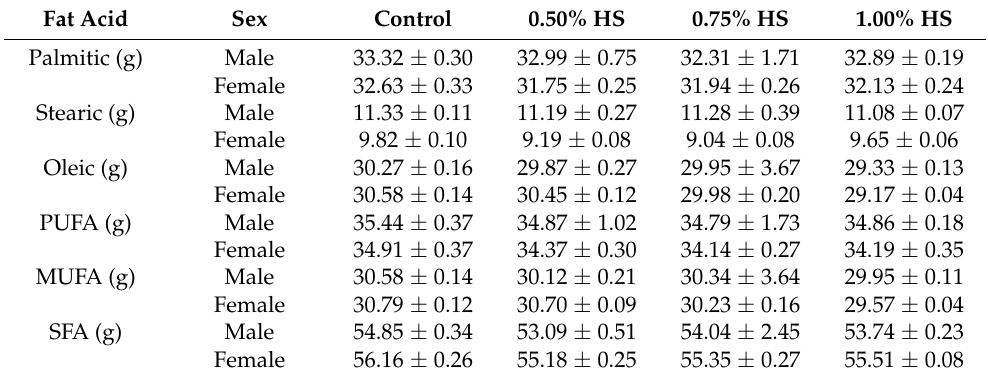
Table 7. The effect of HS on the content of fat acids in thigh